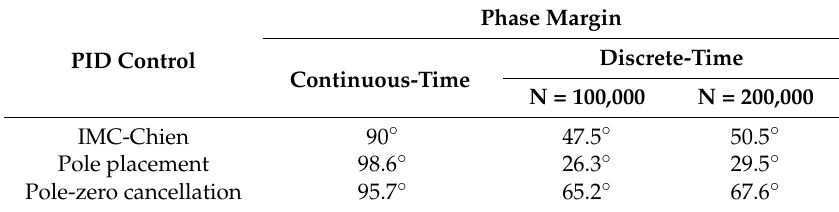
Table 3. Phase margin variations from continuous to discrete-time control using backward Euler’s discretization method.